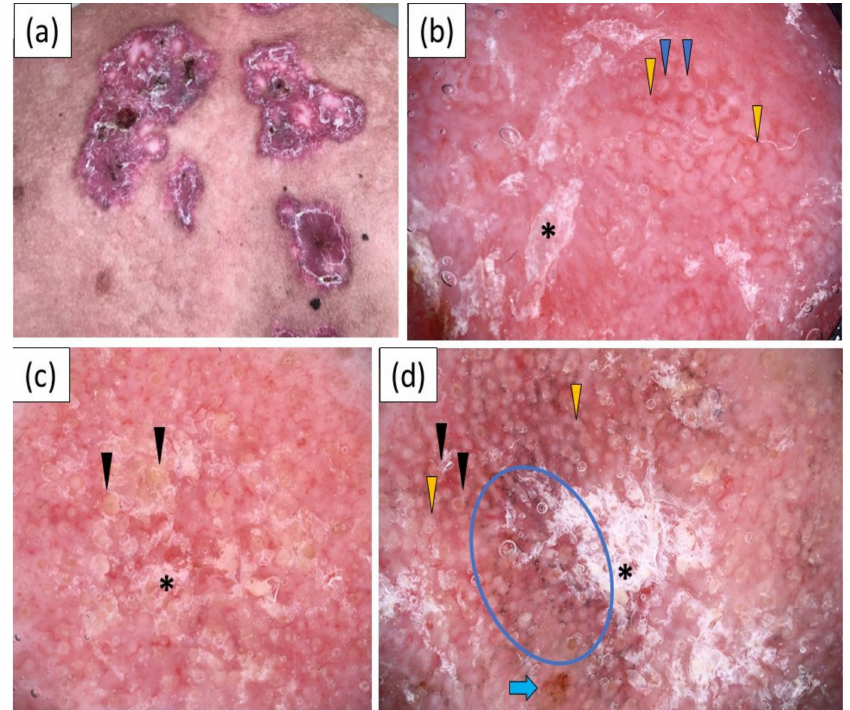
Figure 3. ( a ) Clinical presentation of chronic cutaneous lupus erythematosus (CCLE) on the back; ( b – d ) show videodermoscopic images: ( b ) videodermoscopy showing white scales (black asterisk), red follicular dots (blue arrowhead) and perifollicular white halos (yellow arrowhead); ( c ) videoder- moscopy showing whitish scales (black asterisk) and follicular keratotic plugs (black arrowhead); ( d ) videodermoscopic findings: white scaling (black asterisk), follicular plugs (black arrowhead), white perifollicular halo (yellow arrowhead), gray–brown dots (blue circle) and erosion (blue